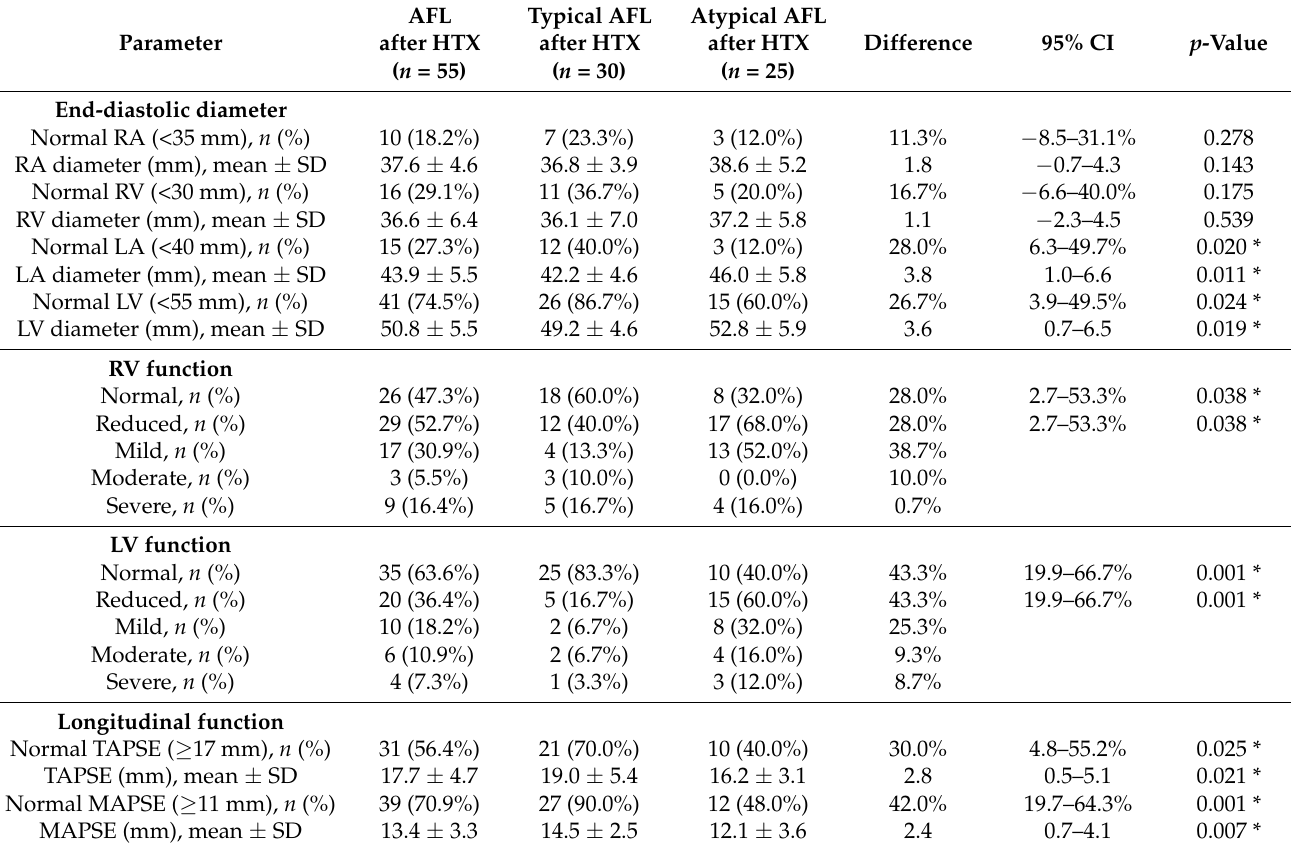
Table 6. Echocardiographic features of patients with late-onset AFL after